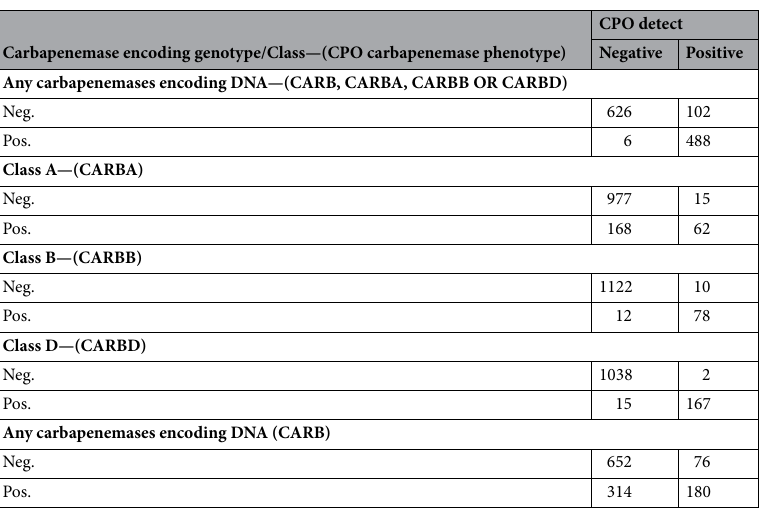
Table 1. CPO panel for (i) detection or (ii) classification of (un-)classified carbapenemase phenotypes (columns) in 1222 genotyped strains (rows). Phenotypes have been placed in parentheses. The abundancy of phenotypical classifications (CARBA, CARBB and CARBD) in strains with genotypical classes A, B or D are detailed. For basic detection of carbapenemases regardless of their classification, CPO detect results for carbapenemase phenotypes without further details (CARB) or with any of the four possible data outputs (CARB, CARBA, CARBB or CARBD) are compared with the presence or absence of any carbapenemase encoding DNA, i.e., regardless of the Ambler classification of the